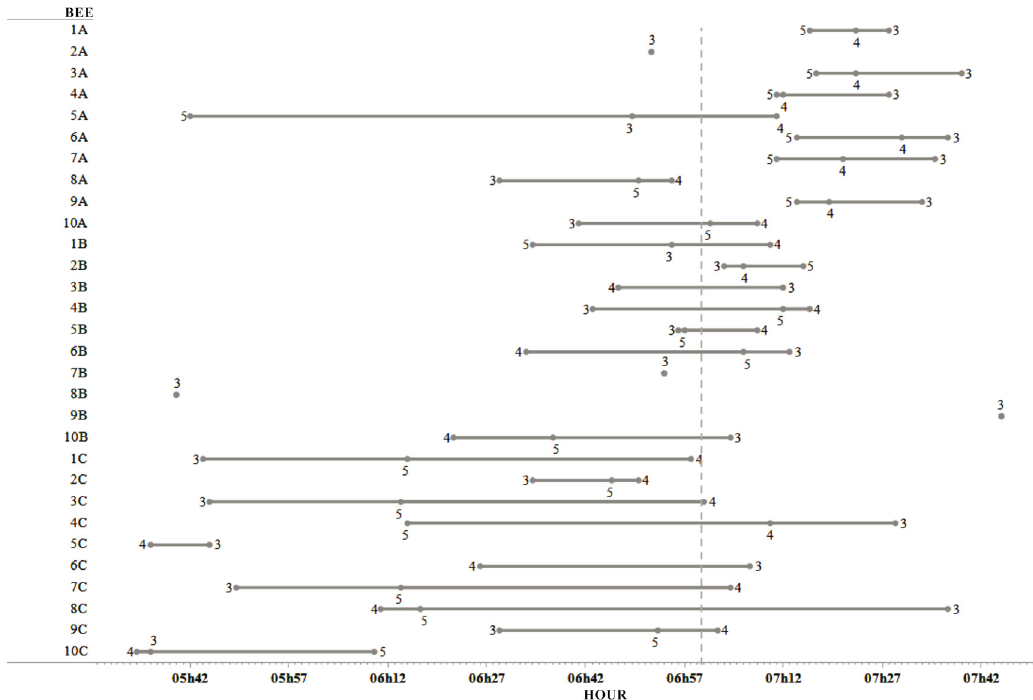
Fig 2 . Individual time of the first visit of each forager of M. subnitida to an artificial feeder on each experimental day (the numbers correspond to the days that occurred or not food-anticipatory activity - 3rd, 4th and 5th